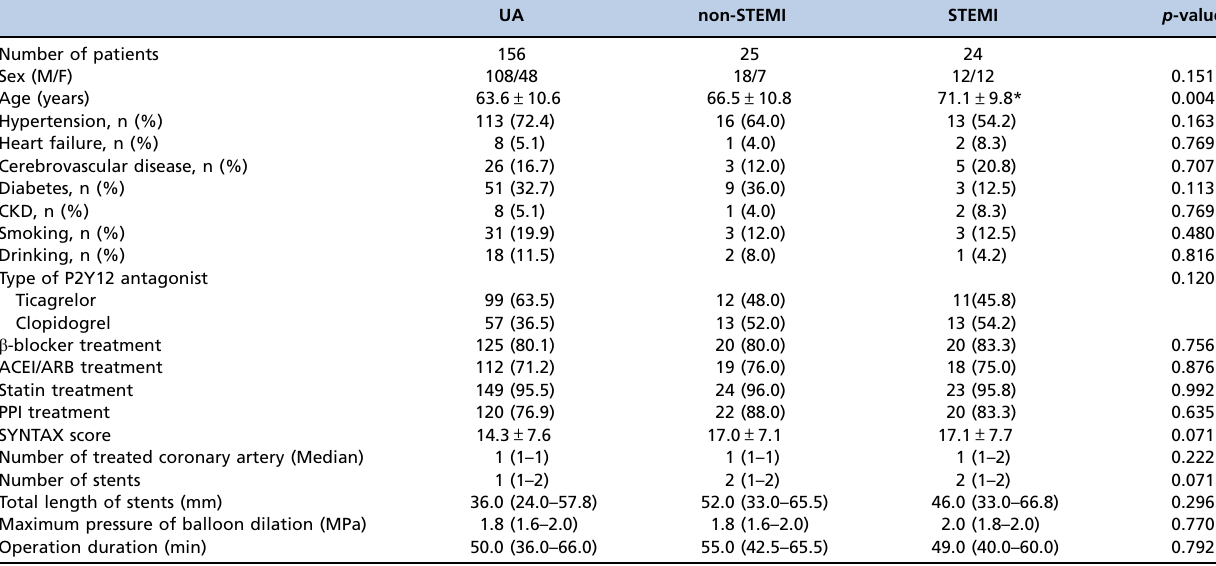
Table 1 - Clinical characteristics of patients at baseline and post-PCI. UA non-STEMI STEMI p -value Number of patients